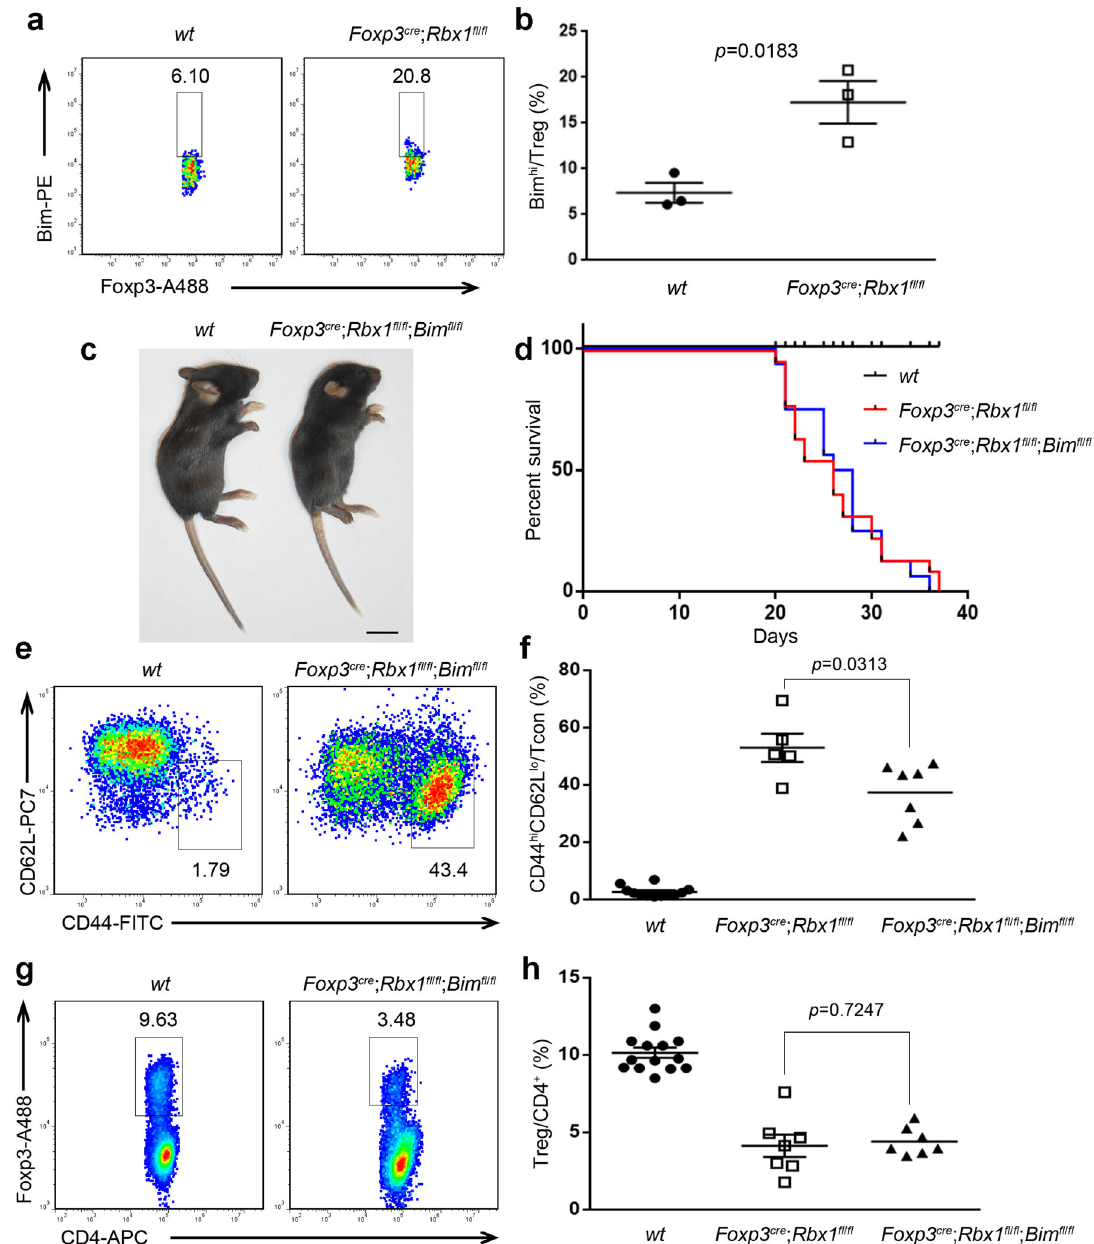
Fig. 6 Involvement of Bim in the phenotypes of Foxp3 cre ; Rbx1 fl / fl mice. a Bim in Treg cells from peripheral lymph nodes of wt and Foxp3 cre ; Rbx1 fl / fl mice (p19, male). b The proportion of Bim hi cells among Treg cells in peripheral lymph nodes from wt and Foxp3 cre ; Rbx1 fl / fl mice (p19 – 21, n = 3 biologically independent samples from both male and female mice). c Representative images of wt and Foxp3 cre ; Rbx1 fl / fl ; Bim fl / fl mice (p23, male, scale bar = 1 cm). d Survival curve of wt , Foxp3 cre ; Rbx1 fl / fl and Foxp3 cre ; Rbx1 fl / fl ; Bim fl / fl mice ( n = 16 animals for Foxp3 cre ; Rbx1 fl / fl ; Bim fl / fl mice from both male and female mice). e Expression of CD44 and CD62L in Tcon cells from peripheral lymph nodes of wt and Foxp3 cre ; Rbx1 fl / fl ; Bim fl / fl mice (p20, male). f CD44 hi CD62L lo /Tcon ratios in peripheral lymph nodes from wt , Foxp3 cre ; Rbx1 fl / fl and Foxp3 cre ; Rbx1 fl / fl ; Bim fl / fl mice (p19-23, n = 11, 4, or 7 biologically independent samples respectively from both male and female mice). g The proportion of Treg cells among CD4 + -T cells from peripheral lymph nodes of wt and Foxp3 cre ; Rbx1 fl / fl ; Bim fl / fl mice (p20, male). h Treg/CD4 + ratios in peripheral lymph nodes from wt , Foxp3 cre ; Rbx1 fl / fl and Foxp3 cre ; Rbx1 fl / fl ; Bim fl / fl mice (p19 – 23, n = 13, 6, or 7 biologically independent samples respectively from both male and female mice). All error bars represent the SEM, data are presented as mean values + / − SEM. The p values were calculated by Mann – Whitney test. Source data are provided as a Source Data fi